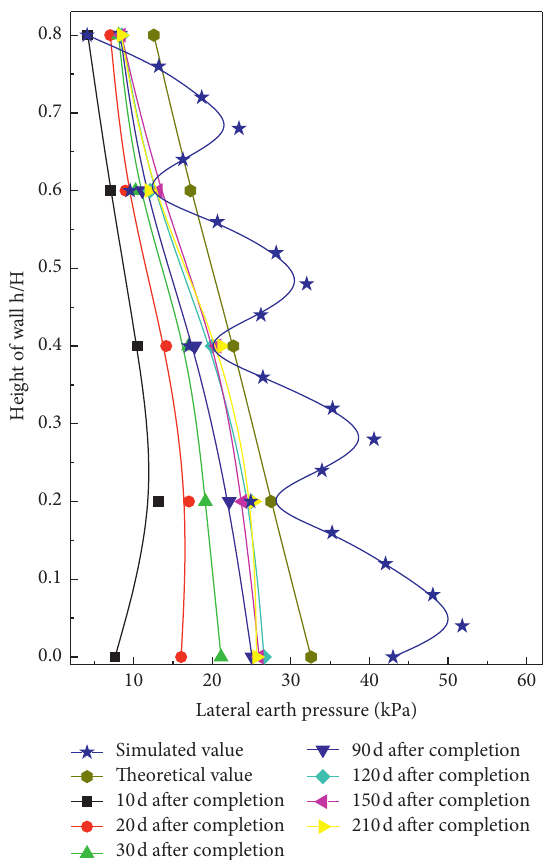
Figure 12: Variation in the lateral Earth pressure at the back of the wall (4m away from the retaining wall surface) with completion time.